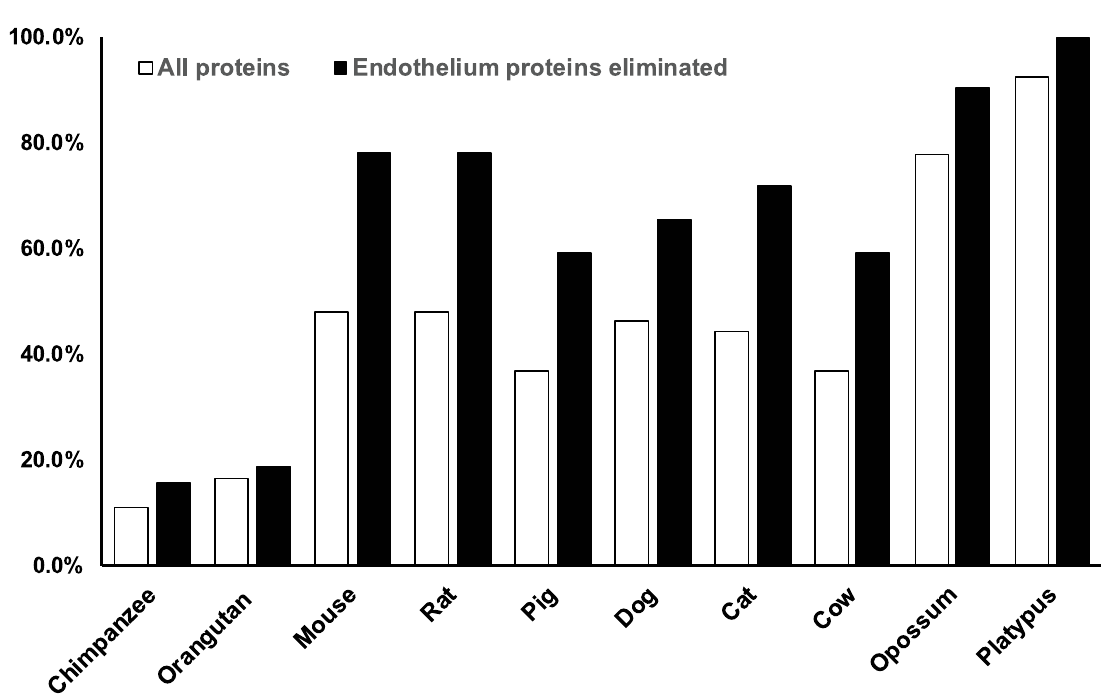
Fig 7. Divergence of a set of vascular proteins from human among 10 species. We analyzed the 54 proteins that demonstrated lack of an orthologue in at least one species. For each species, we summed the number of genes without an orthologue with the number of genes with sequence similarity (versus human) under 70%. The graph displays the percentage of proteins which are predicted to be absent or highly divergent for each species listed. White bars show divergence of all proteins in the set of 54; black bars show divergence of the combination of EC/VSMC and VSMC-only proteins (32 of the 54